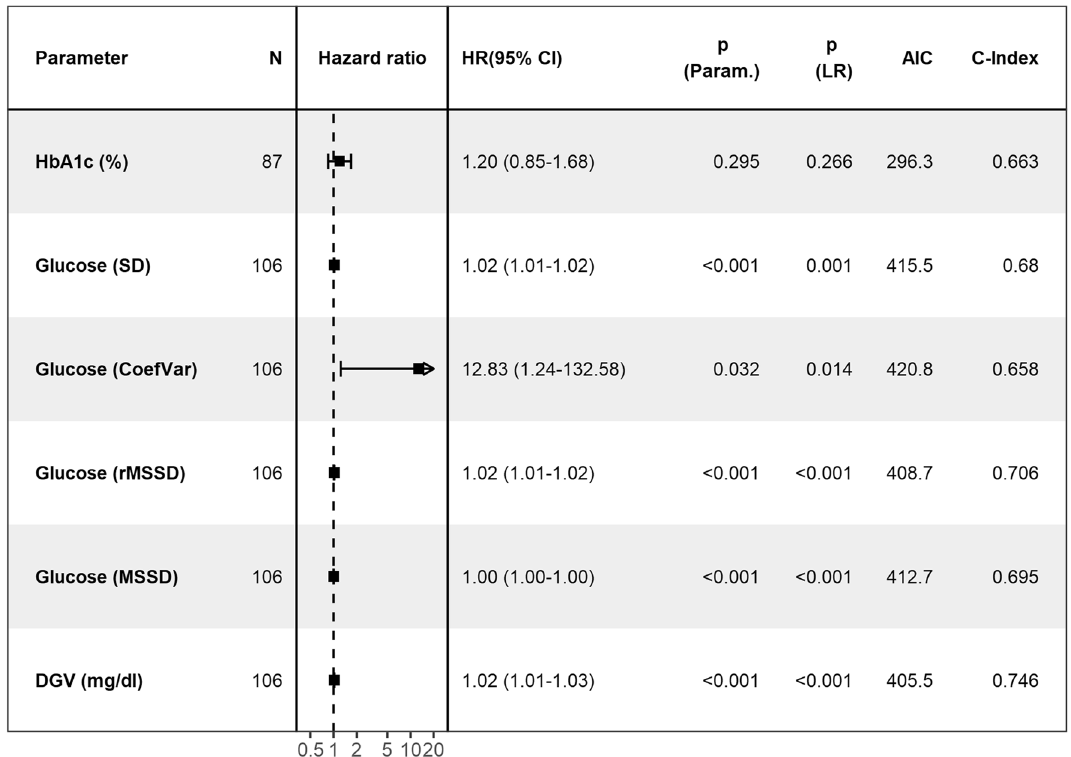
Figure 2. Comparison of HbA1c and variability metrics. Comparison of multivariable Cox-Proportional Hazard models, adjusted for age, sex and history of type 2 diabetes, for HbA1c and established variability metrics: standard deviation (SD), bias corrected Coefficient of Variation (CoefVar), Neuman’s (root) Mean Square of Successive Differences (rMSSD and MSSD) and median of the absolute successive difference between successive values (= DGV, daily glycaemic variability). Includes Hazard Ratio and 95% confidence intervals, p -value for the parameter and likelihood ratio test (LR), Akaike Information Criterion (AIC) and concordance index